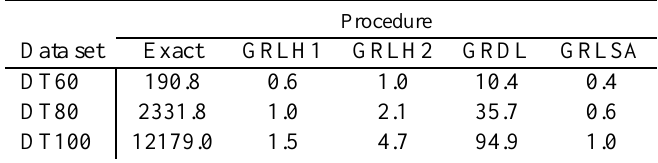
Table 13. Average CPU times for small instances.